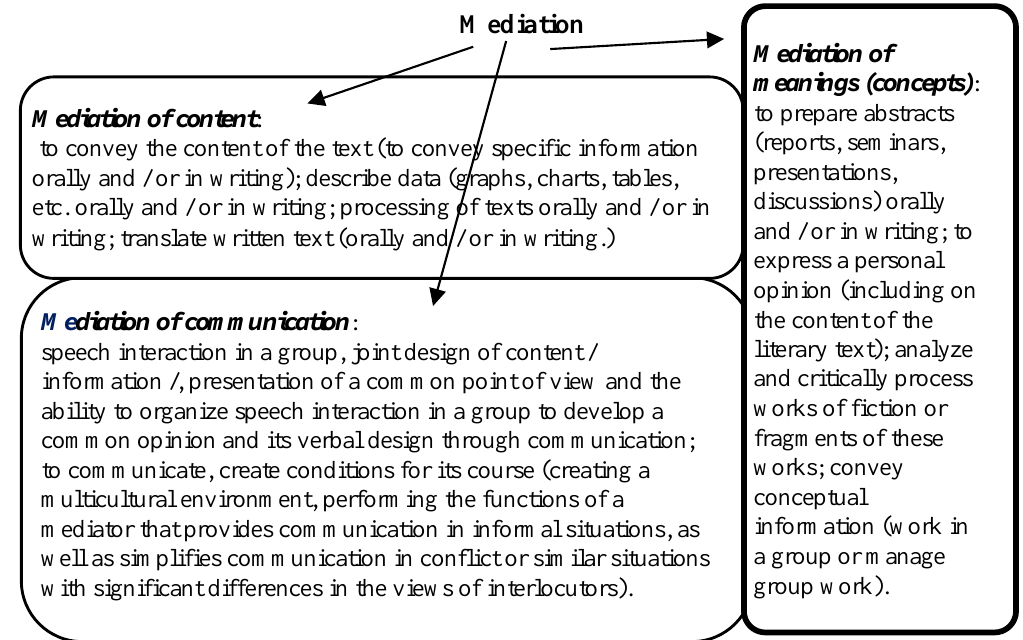
Fig. 1 Three aspects of concept of "mediation"and their main activities [43: 109- Presentation of paper 123]. Figure 59: